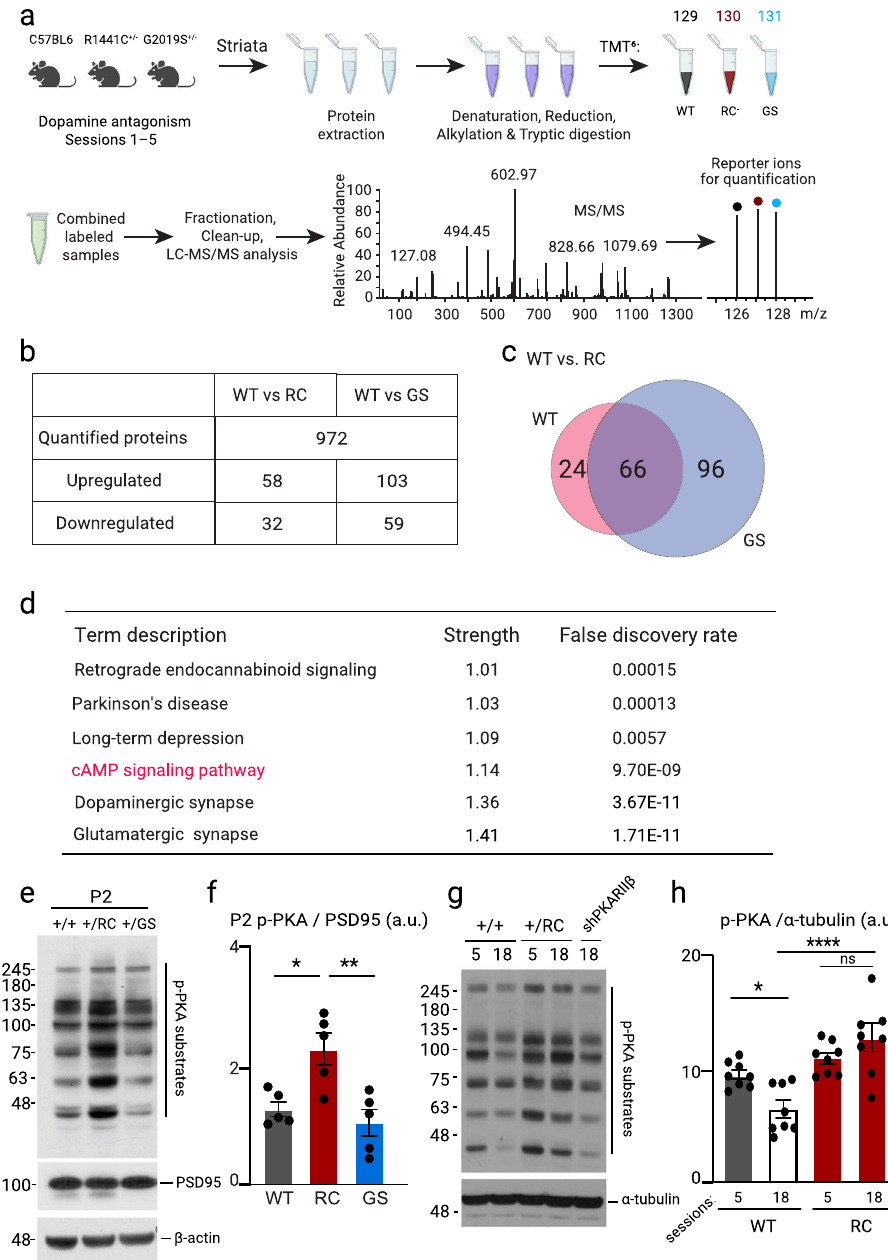
Fig. 4 Synaptic PKA signaling is increased in the striatum of RC mice trained in the rotarod task. a Work fl ow of proteomic screening for total TMT- labeled peptides in WT, RC, and GS striatal crude synaptosomal fraction after 5 days of cocktail (D1R and D2R antagonists) administration and rotarod training. b Pairwise comparisons of WT vs. RC and WT vs. GS proteins revealed that 90 proteins for WT vs. RC and 162 proteins for WT vs. GS were differentially regulated. These fi ndings were further quanti fi ed if the proteins were up- or down-regulated. c Venn diagrams show the overlap of modulated (both up and down-regulated) proteins between WT versus RC and WT versus GS comparisons. 66 differentially regulated proteins were common between the WT vs. RC and WT vs. GS groups. d KEGG analysis of selective pathways altered in RC synaptosomal fraction compared to WT. The top enriched pathways are found in Supplementary Fig. 8, while the full lists of differentially expressed proteins and pathways in WT versus RC and WT versus GS can be found in Supplementary F 1 and 2. e WB analysis of striatal P2 fraction of WT, RC, and GS mice after the rotarod paradigm probed for p-PKA, PSD95, and β -actin. f Quanti fi cation of p-PKA band intensities normalized to PSD95. Summary graphs represent the mean, while error bars SEM, * p < 0.05, Tukey post hoc following one-way ANOVA ( n = 5). g Western blot analysis of striatal extracts of D1 + D2 receptors antagonists administered WT, RC and RC injected with shPKARII β probed for p-PKA substrates. Session 5 refers to the end of the drug phase of the rotarod, whereas session 18 denotes the end of the rotarod behavioral test. h Quanti fi cation of p-PKA bands normalized to α -tubulin in striatal extracts of WT and RC mice after session 5 and 18 of the rotarod task described in Fig. 3. Summary graphs re fl ect the mean, and error bars re fl ect SEM. * p < 0.05, **** p < 0.0001, Tukey post-hoc test following one- way ANOVA ( n =